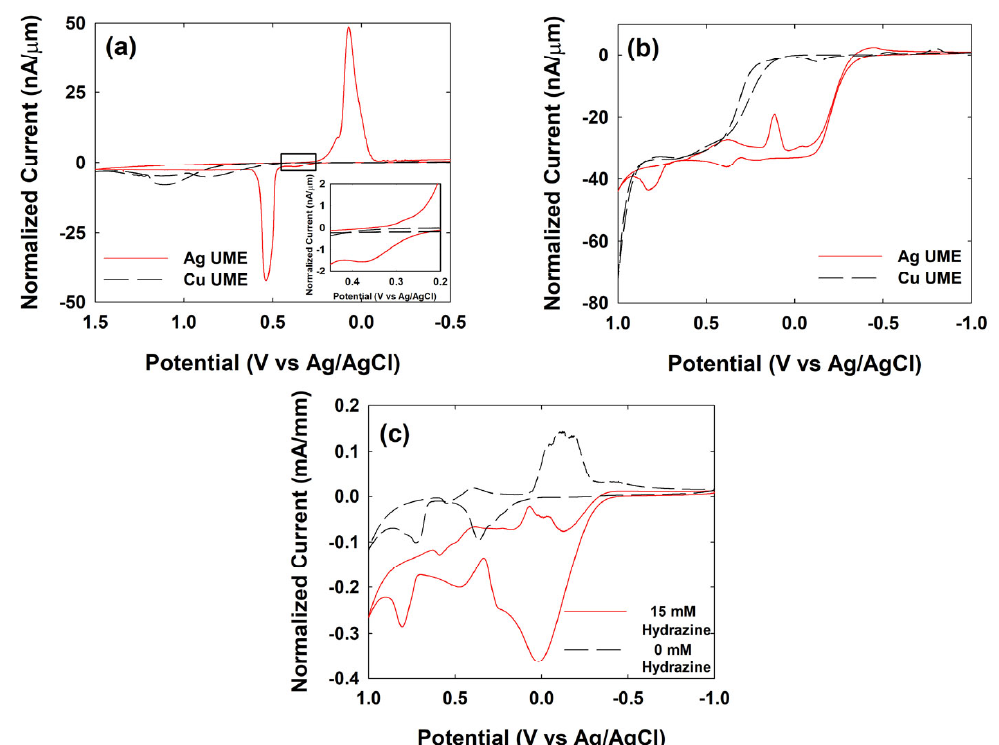
Figure 1. Cyclic voltammograms of Ag UME (red solid) and Cu UME (black dashed) in ( a ) 50 mM PB or ( b ) 0.1 M NaOH solution containing 15 mM hydrazine. The current was normalized based on the radius of UMEs (radius: 7.5 μ m for Cu and 12.5 μ m for Ag). ( c ) Cyclic voltammograms of Ag NP modified GCE in 0.1 M NaOH with (red solid) and without (black dashed) 15 mM hydrazine. The diameter of GCE is 3 mm. The scan rate was 0.1 V/s.